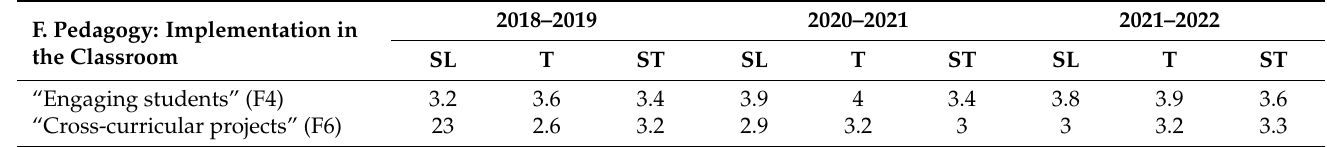
Table 7. Descriptive statistics on Pedagogy: Implementation in the classroom. F. Pedagogy: Implementation